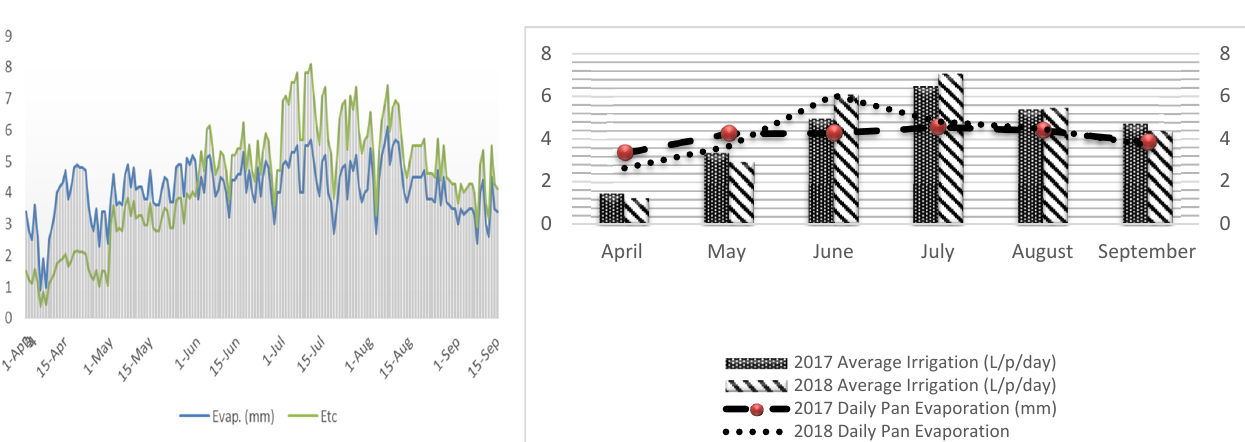
Figure 2. Average daily irrigation requirement (liter/plant/day) and pan evaporation for apple during the growing period. Table 1. Mechanical composition of soil.